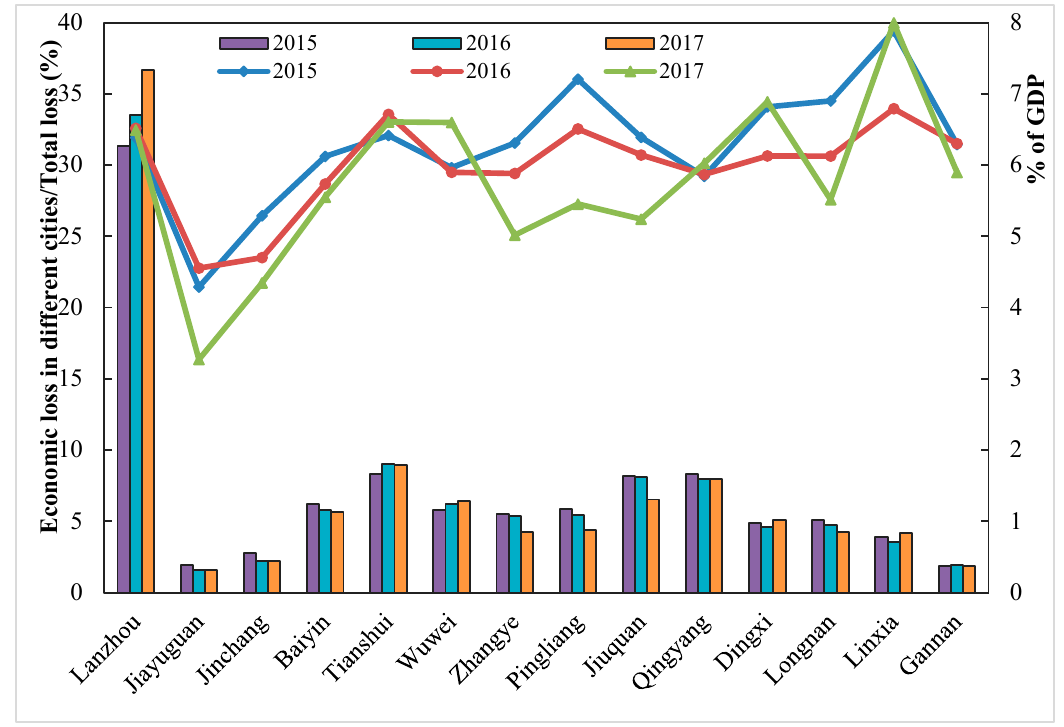
Figure 6. Ratio of economic loss of each city in the total economic loss and the ratio of economic loss to GDP from 2015 to 2017.